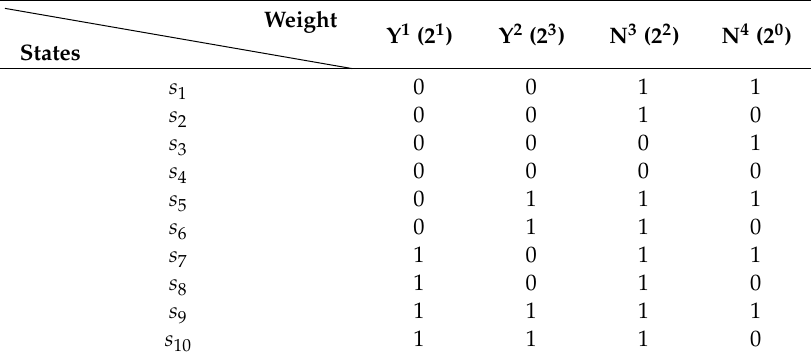
Table 5. True values of states for the public.